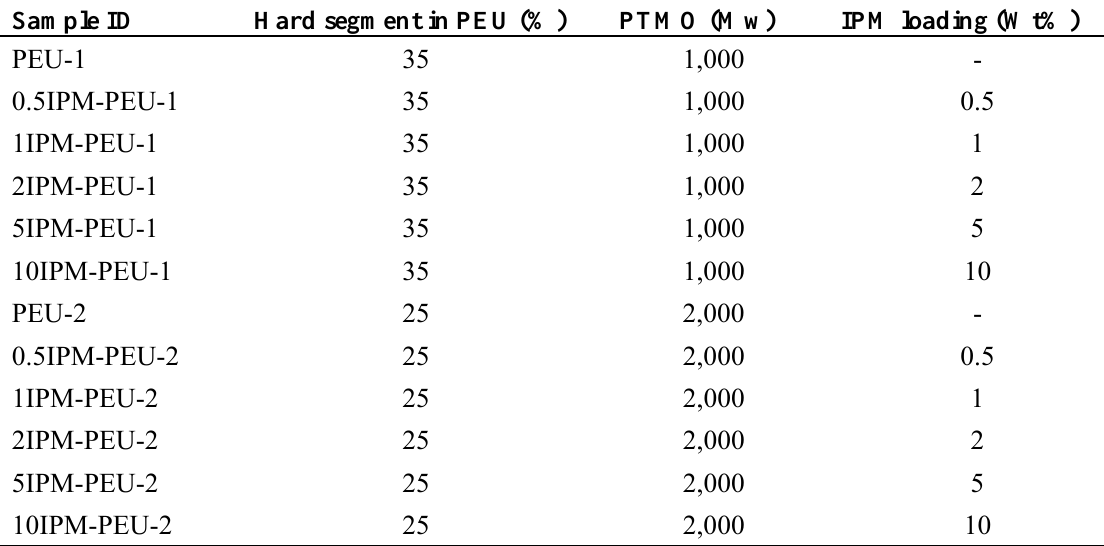
Table 1. IPM loaded